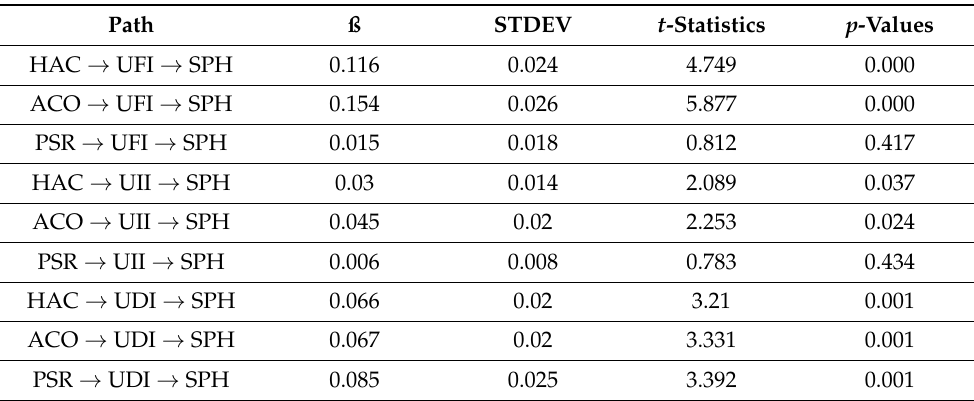
Table 7. Mediation effect